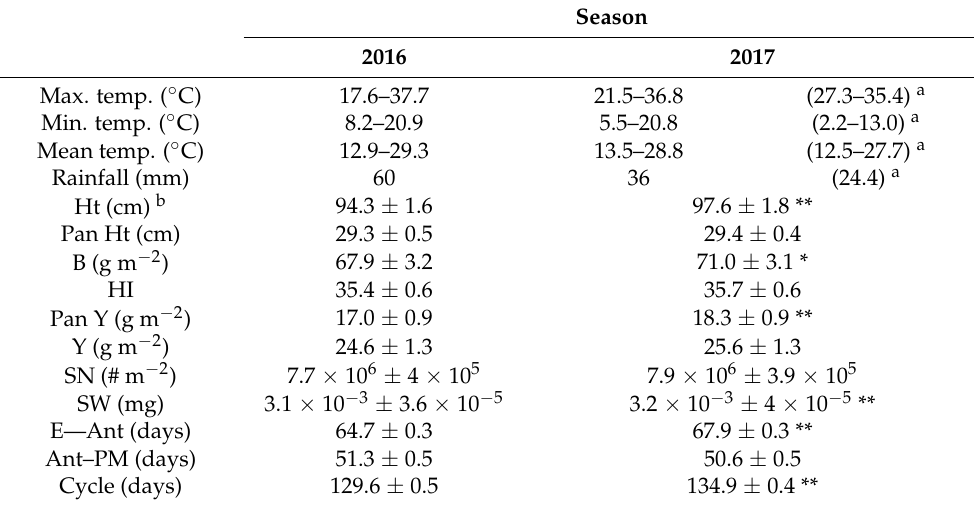
Table 1. Growing conditions in Faisalabad and their effect on measured phenotypic traits. Maximum, minimum and mean temperature are ranges of monthly values whereas rainfall are totals for the growing season (November–April). For phenotypic traits the values are shown as means ±